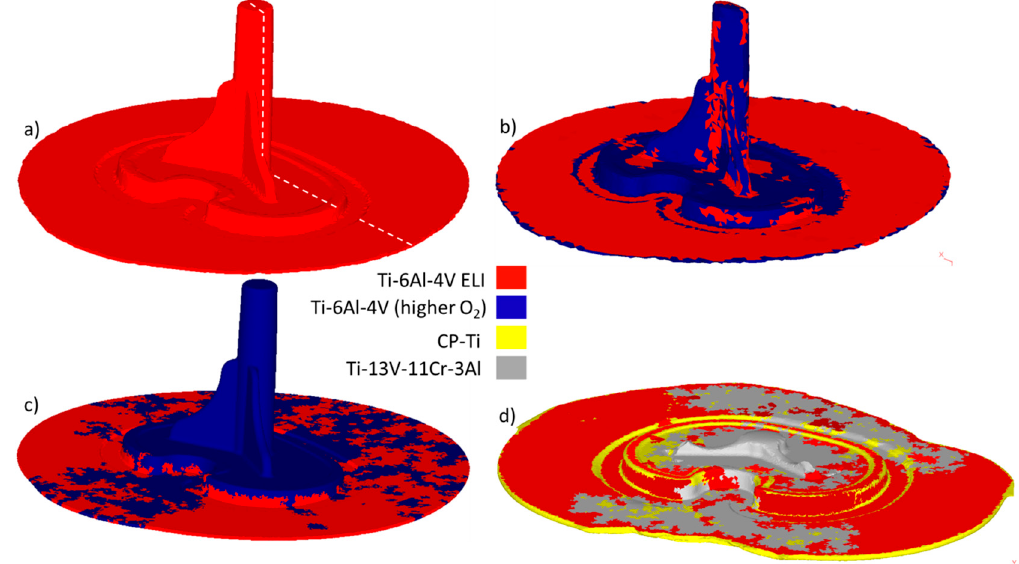
Figure 6. Isometric view of the material partitions of ( a ) Model 1, ( b ) Model 2, ( c ) Model 3, and ( d ) Model 4.